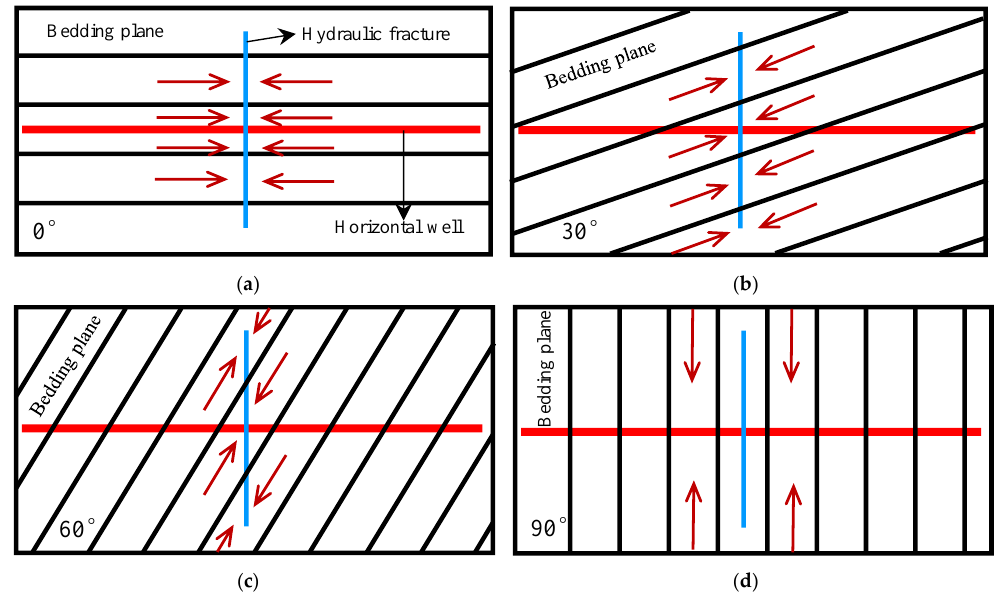
Figure 8. Fractured horizontal well at different angles to bedding plane of shale gas reservoir ( a ) dip of 0°; ( b ) dip of 30°; ( c ) dip of 60°; ( d ) dip of 90° (red arrows represent permeability parallel to bedding plane).